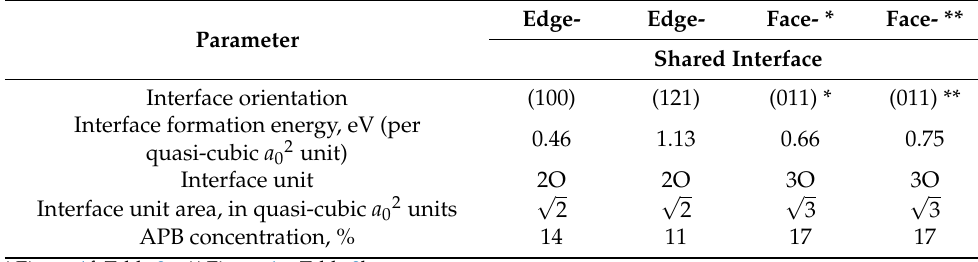
Table 4. Calculated relative to the ideal LaScO 3 bulk, APB interface energy in eV per surface unit. Edge- Edge- Face- * Face- ** Parameter Shared